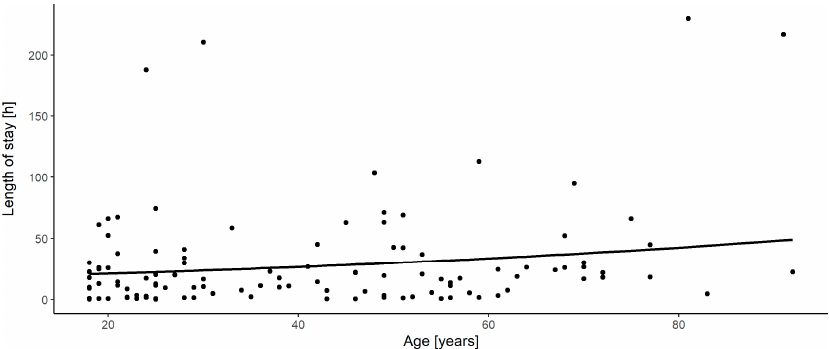
Figure 3. Correlation between length of stay and age of patients. The solid line (regression line) represents the correlation according to the transformed regression coefficient (Table 10).